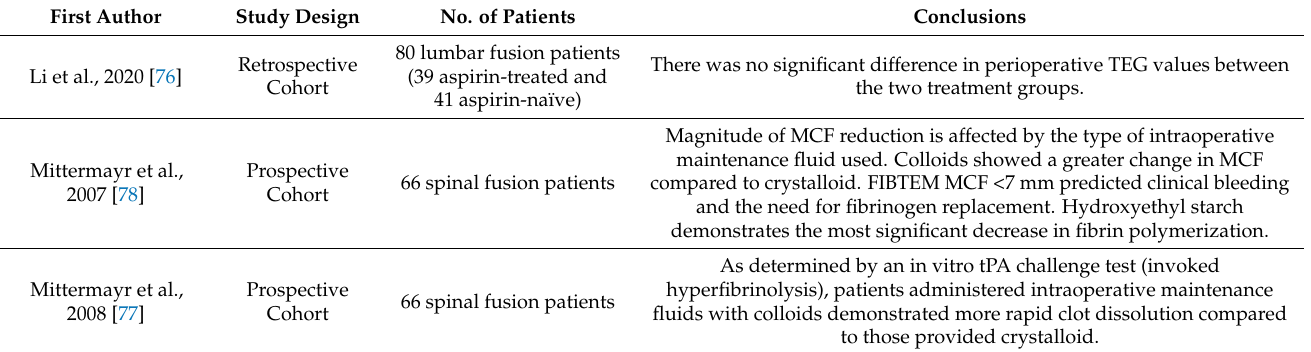
Table 6. Summary of the literature pertaining to viscoelastic hemostatic assays applied to patients undergoing spine